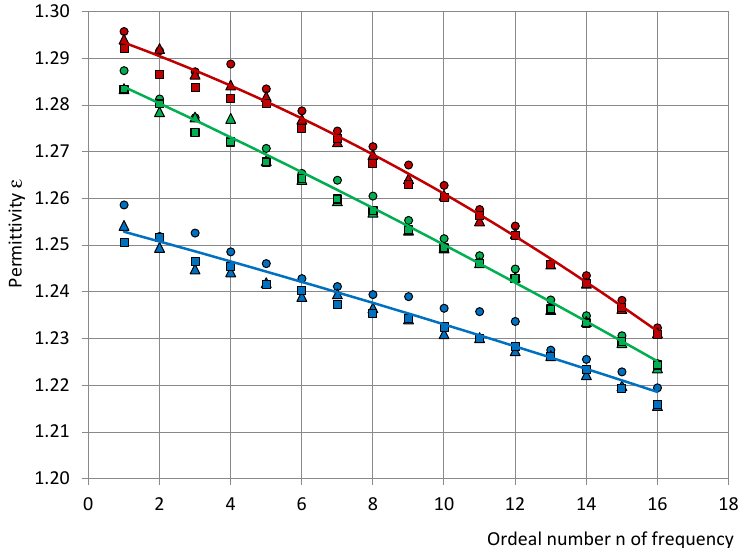
Figure 2. The permittivity spectra of PU SikaBlock ® -M150 foams (density of 144 kg/m 3 ) at a relative humidity of atmosphere in the test room RH: (1) 21% (blue), (2) 50% (green), and (3) 60% (red). Markers—data points of the three permittivity spectra of a short series; the continuous lines—the averaged and approximated permittivity spectra.